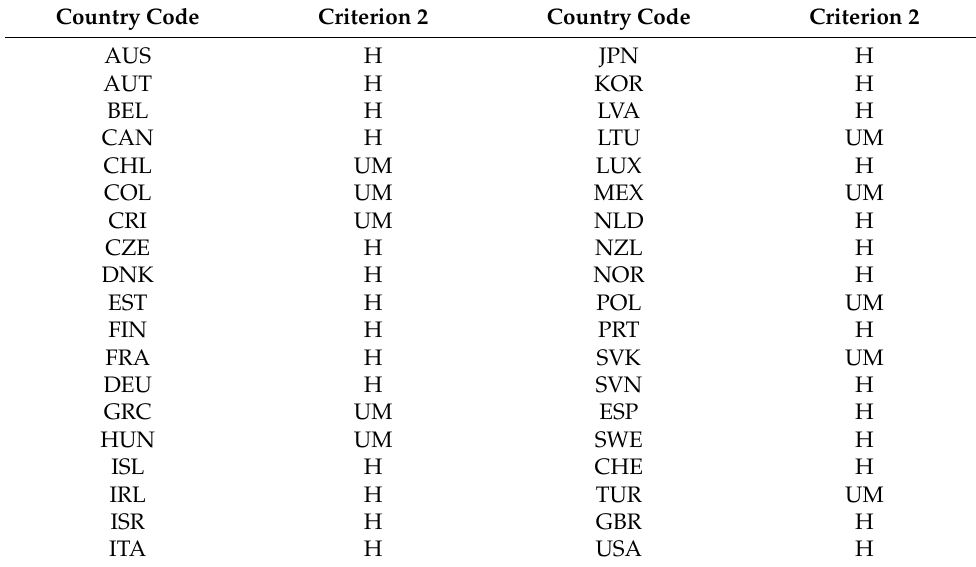
Table 13. Output first Type-1 FIS Criterion 2.